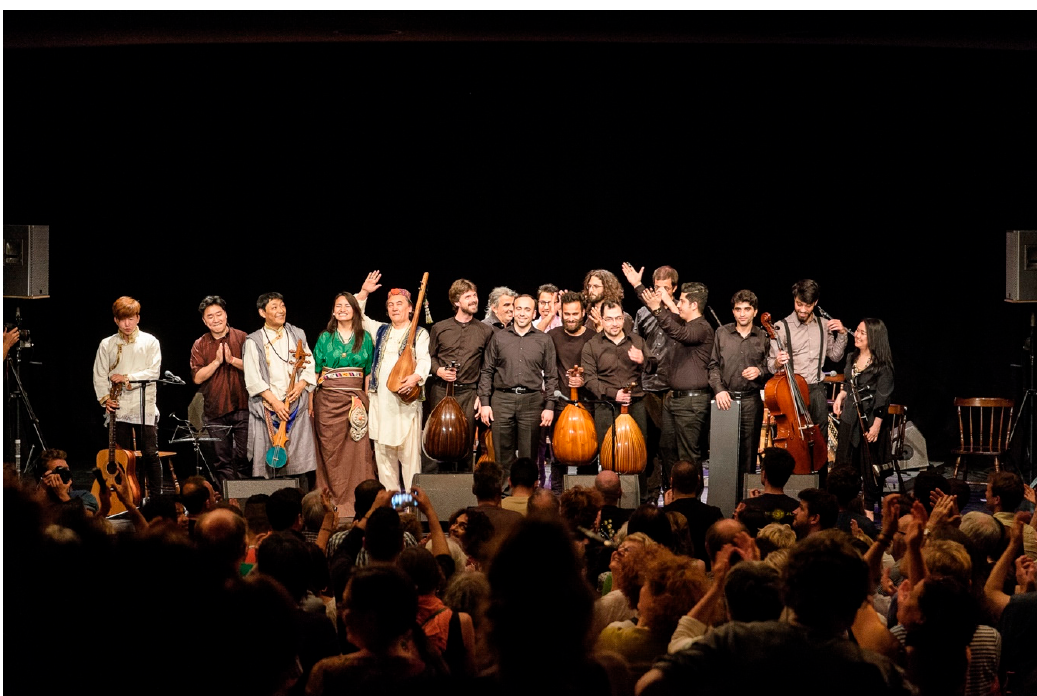
Figure 1. Refugees for Refugees during the CD release concert (Muziekpublique, Brussels, 13 May 2016). On stage: 17 musicians from 8 countries playing 15 different types of musical instruments and singing in 3 languages. Among them: 5 asylum seekers waiting for a decision, 8 having obtained the administrative “refugee” status, 3 Belgians, 1 stateless person. Credits: Jean-Luc Goffinet and Muziekpublique (used by permission).